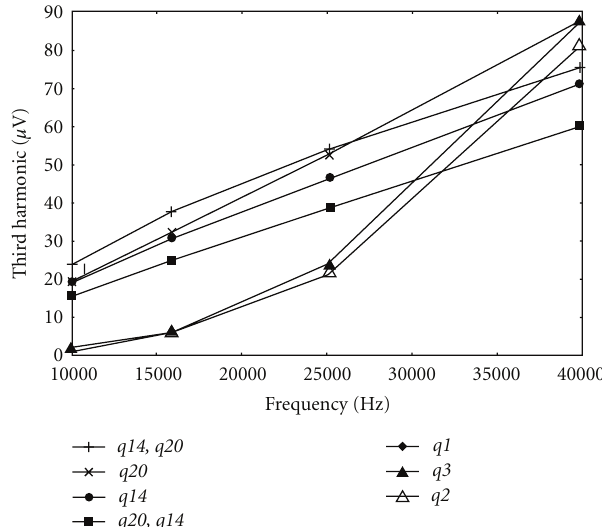
Figure 7: Contributions to the third